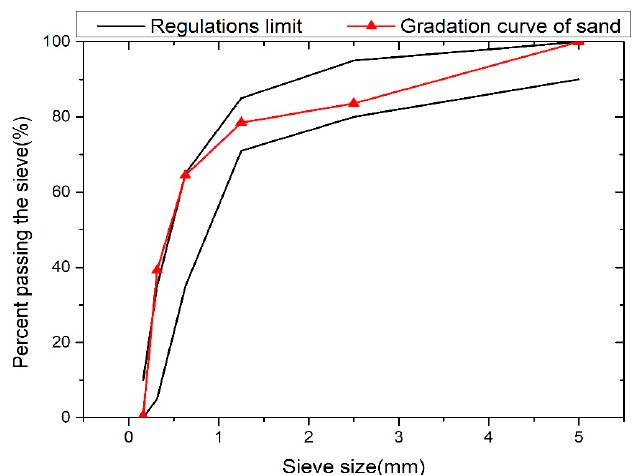
Figure 1. Preparation of recycled aggregate.